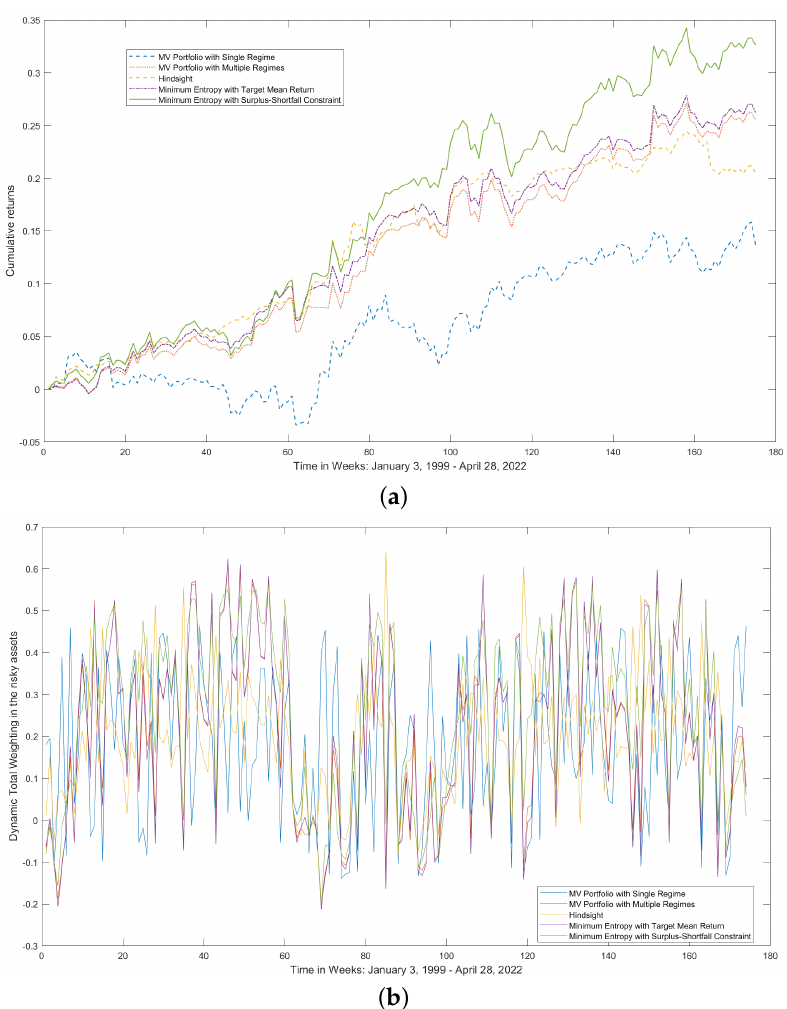
Figure 4. Cumulative Portfolio Returns and Net Weighting. ( a ) Cumulative returns; ( b ) Net